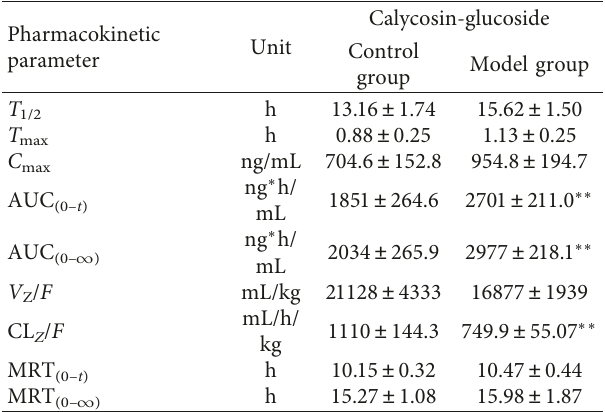
Table 9: The pharmacokinetic parameters of calycosin-glucuronide after HQD administration ( x ± SD, n � 8).